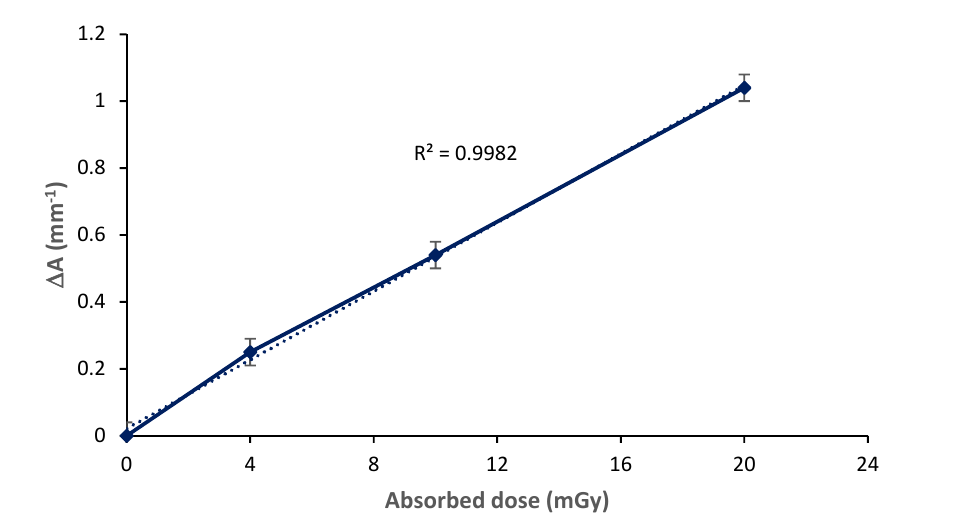
Figure 4. Dose–response curve based on UV-Vis absorption capacities at λ max for PVA/Ag + /NBT films exposed at various X-ray doses.